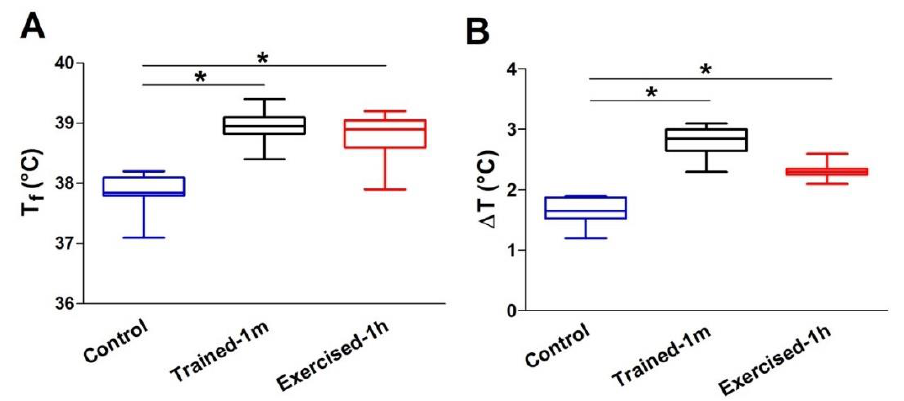
Figure 1. Average core temperature of mice following the ES protocol: ( A ) Average absolute core temperatures recorded at the end of the ES protocol (T f ); ( B ) average changes in core temperature ( ∆ T) during ES protocol, i.e., the difference between temperatures measured at the beginning (T 0 ) and at the end (T f ) of the experiment. Data are shown as follows: (i) the box extends from the 25th to 75th percentiles; the line in the middle of the box is plotted at the median, and the whiskers go down to the smallest value and up to the largest (graphs in ( A ) and ( B ); (ii) mean ± SEM (* p < 0.05, as evaluated by two-tailed unpaired Student’s t -test). Sample size (number of tested mice): control = 8; trained-1 m = 8; exercised-1 h = 9.